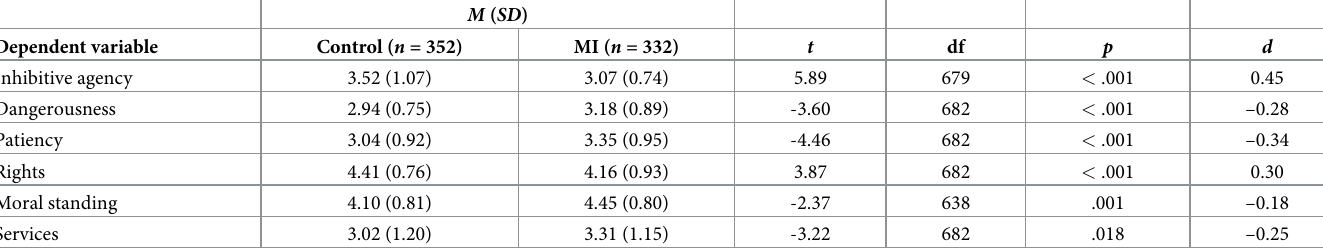
Table 8. Descriptive and t-test statistics for dependent variables (Study 3).